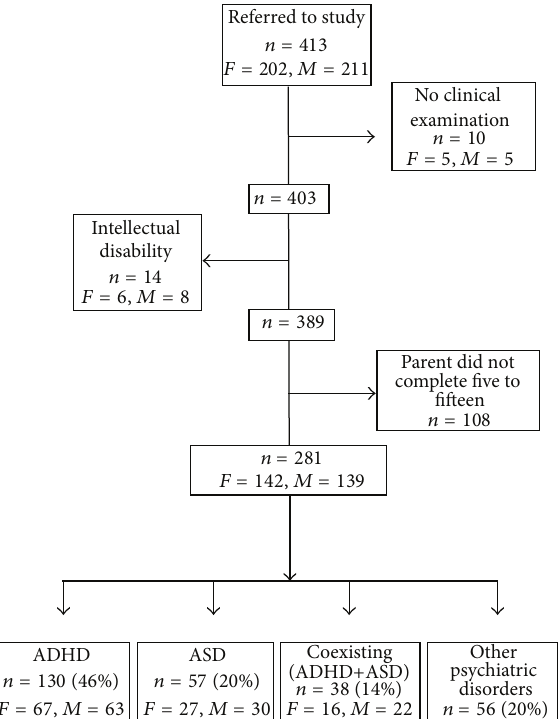
Figure 1: Flow scheme for